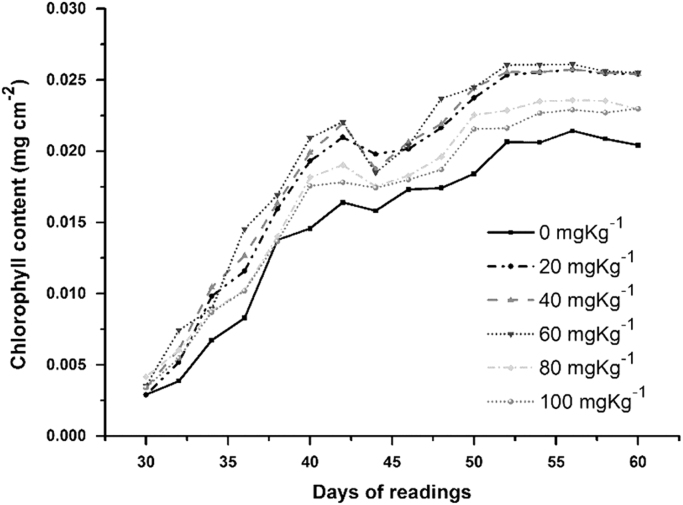
Effect of TiO2 NPs treatments on foliar chlorophyll content of wheat on daily basis.